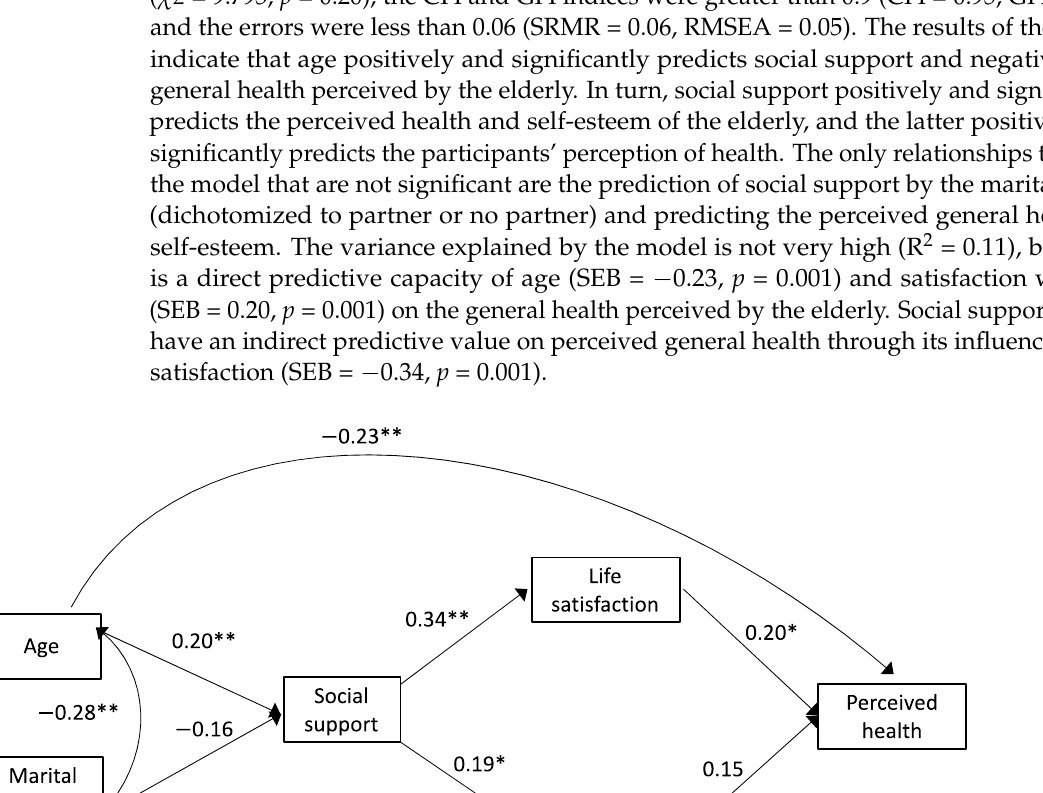
Table 2. Correlations between the study variables.